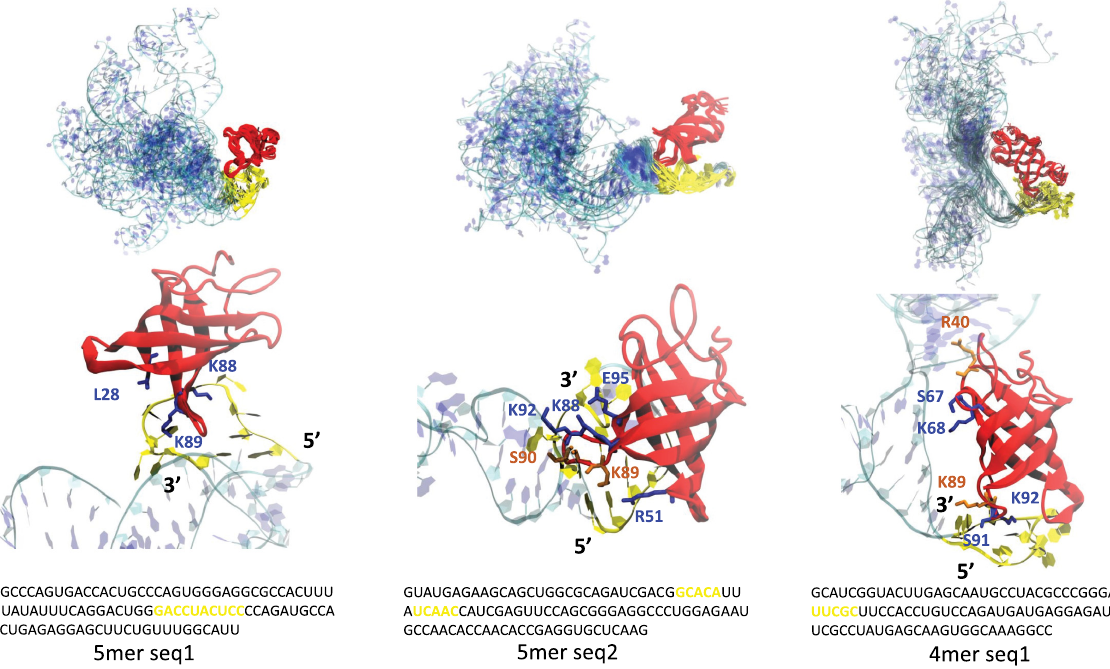
Fig 7. Complex simulation ensemble of docking of LIN28B CSD domain and three RNA network motifs. MD ensembles and snapshot of the protein-RNA interfaces are show at the top and bottom respectively. LIN28B CSD protein is shown in red and 100 nt RNA shown in cyan and blue. The identified RNA network motifs are shown in yellow in both structure and in